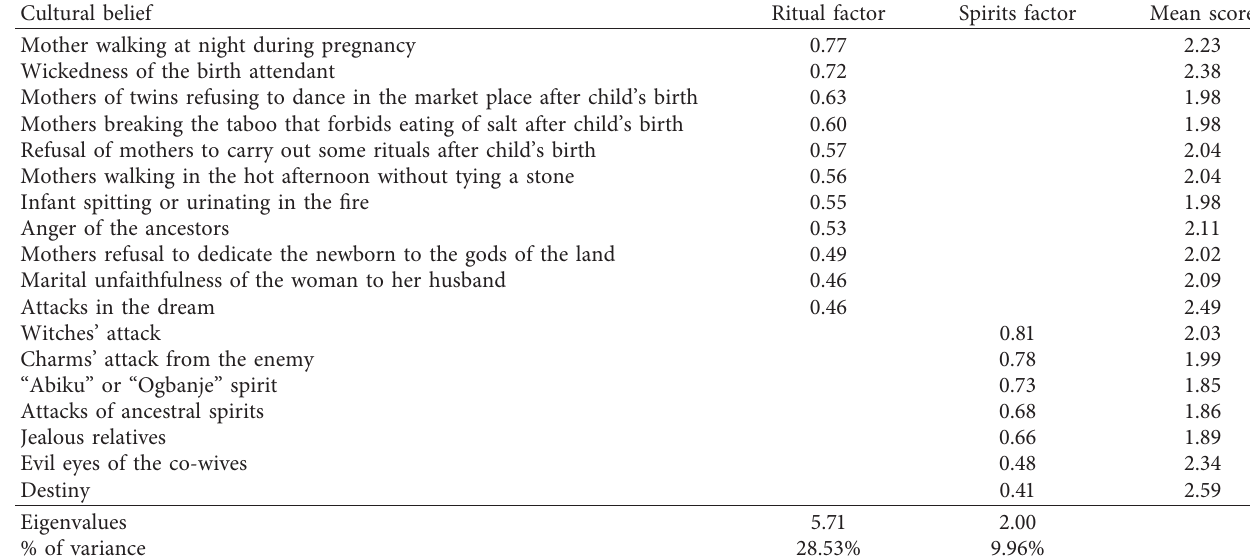
Table 2: Factor loadings and mean scores on cultural beliefs of infant mortality questionnaire items ( N � 2400). Cultural belief